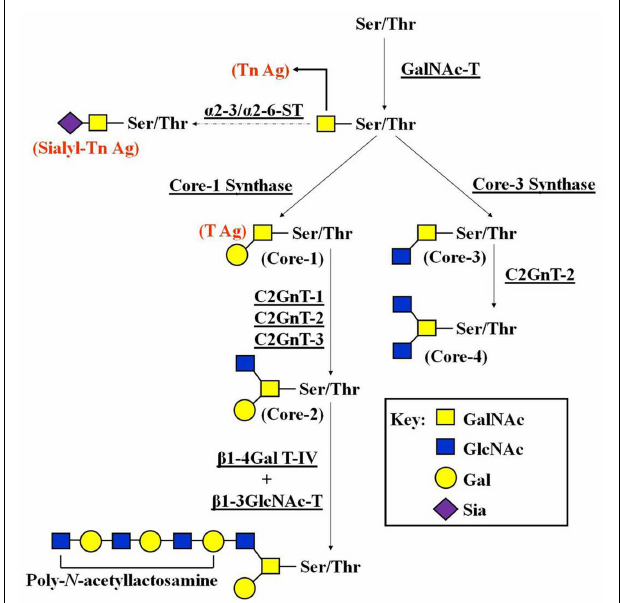
FIGURE 1 | Pathways of O -glycan biosynthesis .To begin synthesis of core-2 and core-4 O -glycans, GalNAc is transferred to a serine or threonine residue in a polypeptide by the GalNAc-T. GalNAc-Ser/Thr is then converted by core-1 synthase to Gal β 1-3GalNAc-Ser/Thr (core-1). Core-1 is converted to core-2 by C2GnT-1, -2, and -3. β -1,4-galactosyltransferase IV ( β 1-4Gal-T IV), together with β -1,3- N -acetylglucosaminyltransferaseV ( β 1-3GlcNAc-T V), synthesizes poly- N -acetyllactosamine on core-2 O -glycans.The number of Gal β 1-4GlcNAc disaccharide unit repeats varies depending on the carrier molecules and cell types. GalNAc-Ser/Thr is also converted by β 3GnT-6 to core-3. Core-3 is then converted by C2GnT-2 to core-4. As discussed in the main text, the accumulation of truncated versions of expressed oligosaccharides (T-,Tn-, and sialylTn-antigens) occurs due to impaired activity of glycosyltransferases involved in the elongation of O -linked